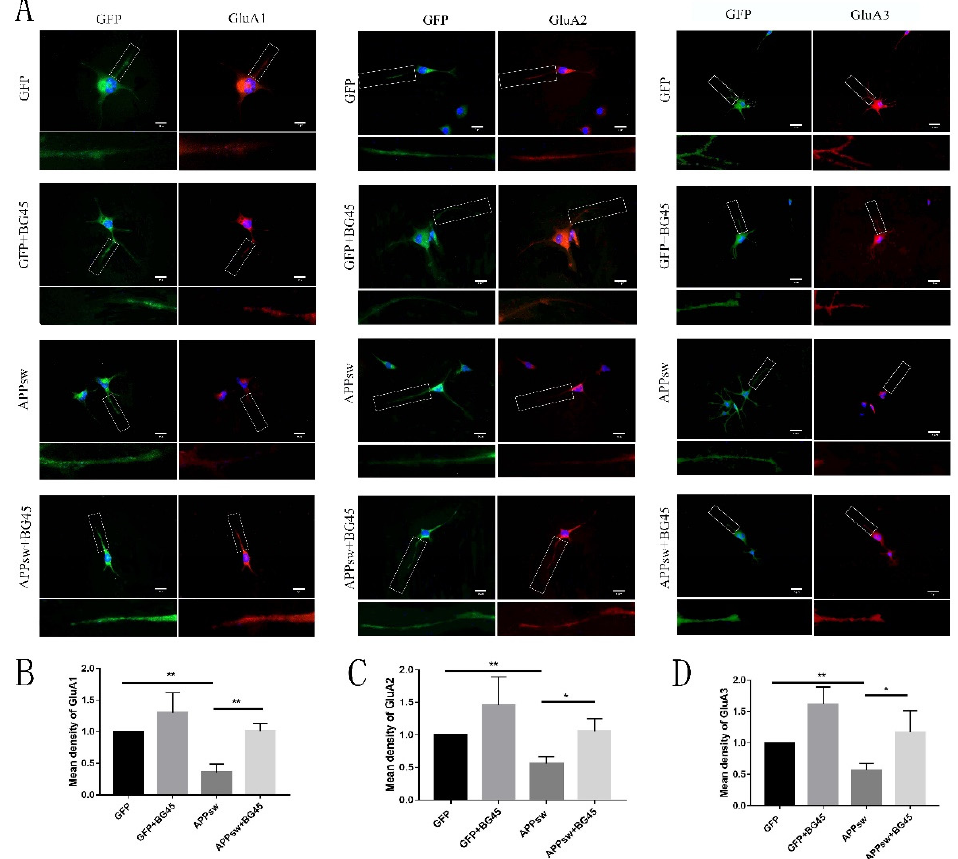
Figure 6. BG45 increased the cell surface levels of AMPA receptor subunits. ( A ) Immunostaining for cell surface GluA1, GluA2, and GluA3 receptors on GFP- and APPsw-positive cells treated with vehicle or BG45 (15 µ M). The lower images show the positive cells magnified in the white box. ( B ) Quantification of the cell surface GluA1 levels. ( C ) Quantification of the cell surface GluA2 levels. ( D ) Quantification of the cell surface GluA3 levels. Scale bar = 50 µ m ( A ). Significant differences were determined using Student’s t -test. All values are presented as the means ± SD from three independent experiments. * p < 0.05, ** p < 0.01.